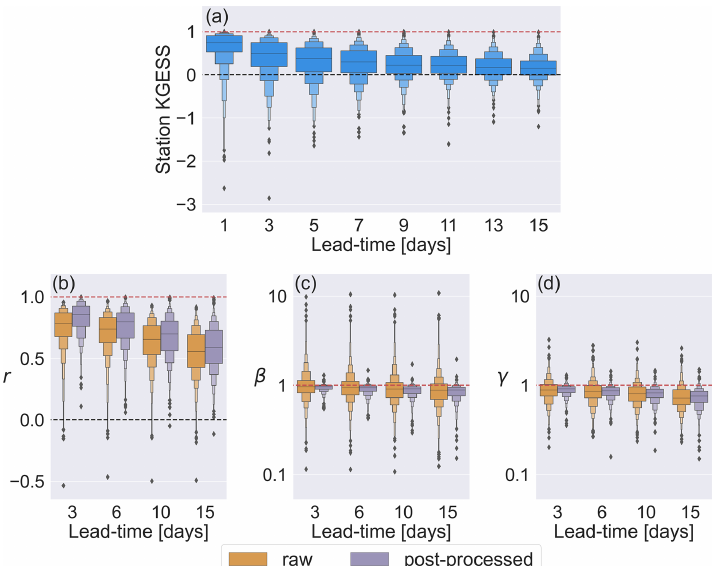
Figure 5. Comparison of the raw and post-processed forecast medians. (a) The Kling–Gupta efficiency skill score (KGESS) for the forecast medians at all 522 stations for every other lead time. Red dashed line shows the perfect score of KGESS = 1. Black dashed lines show a KGESS value of 0. KGESS > 0 indicates that the skill of the forecast median is improved by post-processing. KGESS < 0 indicates that the skill of the forecast median is degraded by post-processing. The three components of the KGE’: (b) correlation component, r . Black dashed line shows r = 0. (c) Bias ratio component, β . (d) Variability ratio component, γ . Red dashed lines show the perfect scores of 1 for all the components. Both panels (c) and (d) have logarithmic y